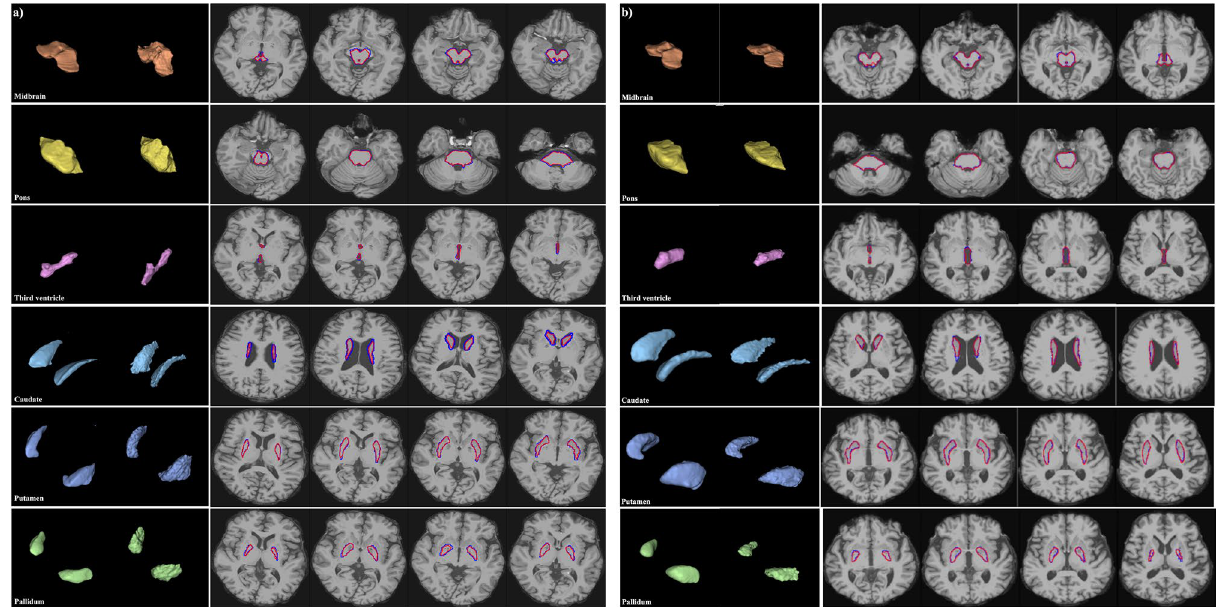
Figure 2. ( a ) Segmentation results of CNN-based V-Net (left 3D images in first column and red-highlighted areas in second column) and FS (right 3D images in first column and blue-highlighted areas in second column) for each brain structure. ( b ) Segmentation results of ViT-based UNETR (left 3D images in first column and red-highlighted areas in second column) and FS (right 3D images in first column and blue-highlighted areas in second column) for each brain structure.